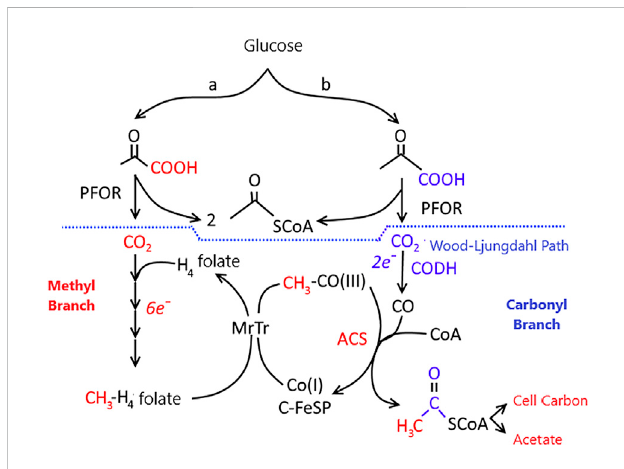
FIGURE 7 The Wood-Ljungdahl pathway of autotrophic CO and CO 2 fi xation. CODH, CO dehydrogenase; ACS, acetyl-CoA synthase; MeTr, methyltransferase; CFeSP, Corrinoid iron-sulfur protein; PFOR, pyruvate ferredoxin oxidoreductase. Letters (A,B) indicate two branches of the Wood-Ljungdahl pathway. Reactions leading to the formation of the methyl group of acetyl-CoA are colored red, while those leading to the carbonyl group are colored blue. Figure redrawn after reference (Ragsdale,